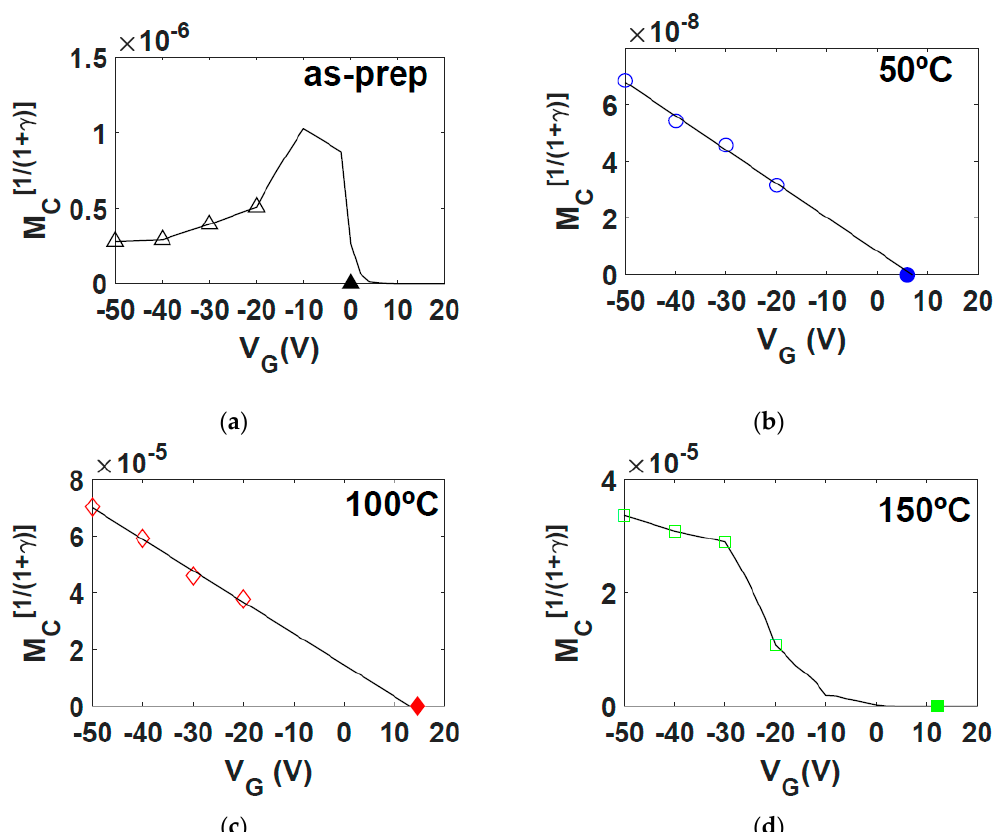
γ ) Figure 9. ( a – d ) Extracted values of 𝑀 (cid:3004) (𝑉 (cid:3008)(cid:3036) ) (cid:2869)/((cid:2869)(cid:2878)(cid:3082)) (empty symbols) at different annealing Figure 9. ( a – d ) Extracted values of M C ( V Gi ) 1/ ( 1 + (empty symbols) at di ff erent annealing temperatures. temperatures. The solid lines show the trend that 𝑀 (cid:3004) must follow for the Equations (5) and (18) to fit The solid lines show the trend that M C must follow for the Equations (5) and (18) to fit the the experimental 𝐼 (cid:3005) − 𝑉 (cid:3008) curves of Figure 5. In (b,c), the lines also follow the trend given in Equation experimental I D − V G curves of Figure 5. In ( b , c ), the lines also follow the trend given in Equation (10). (10). The black symbol drawn on the 𝑉 (cid:3008) -axis of each figure represents the value of 𝑉 (cid:3021) extracted with The black symbol drawn on the V G -axis of each figure represents the value of V T extracted with the the evolutionary procedure. evolutionary